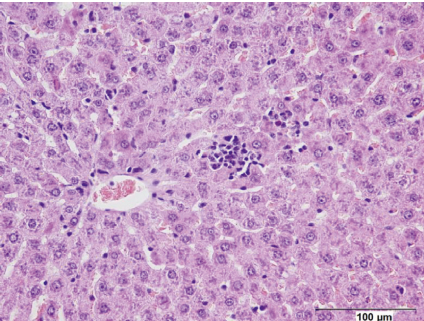
Figure 3: Centrolobular area of the liver tissue with 2 focal he- patocyte necrosis (HE,